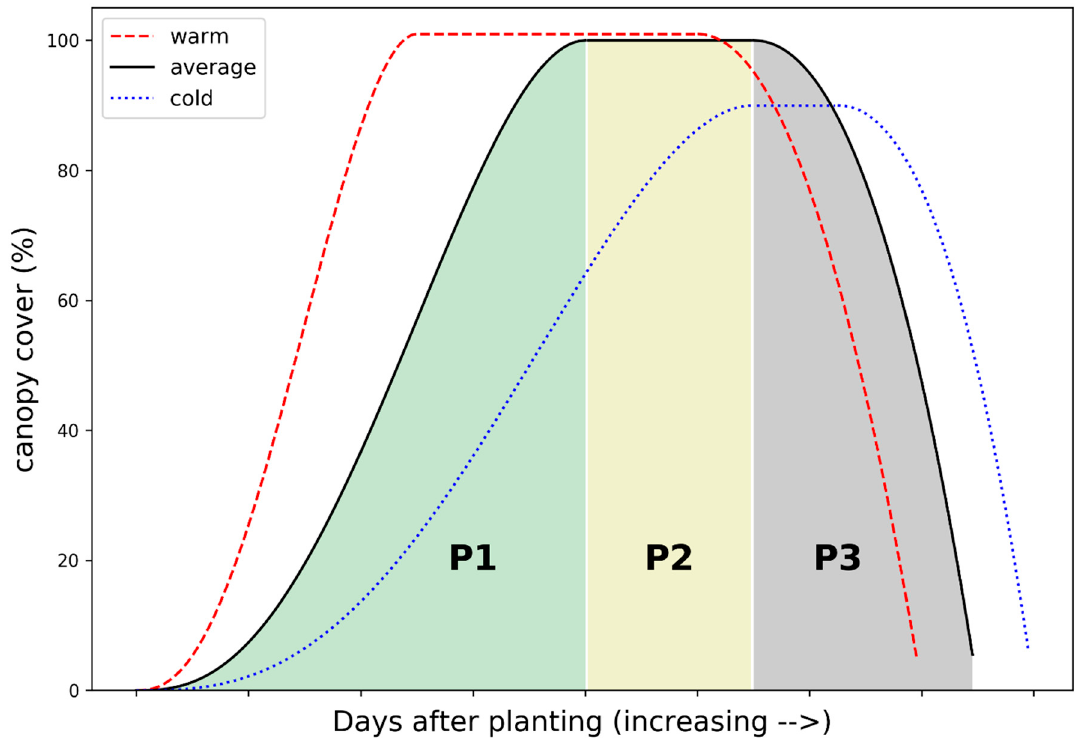
Figure 1. A hypothetical model-based representation of the canopy dynamics expressed in percent canopy cover as a function of days after planting (not scaled) based on the beta function to determinate growth for the canopy buildup phase (P1) [45,53], maximum cover phase (P2), and canopy decline phase (P3) [45], as shown. Note that the break-down into these three phases indicated is only applicable to the ‘average’ curve shown with the solid line. We assumed canopy growth for warm, mild, and cold temperatures scenarios to mimic meteorological conditions in lowlands, midlands, and highlands of potato growing regions in the Gamo Highlands, respectively.